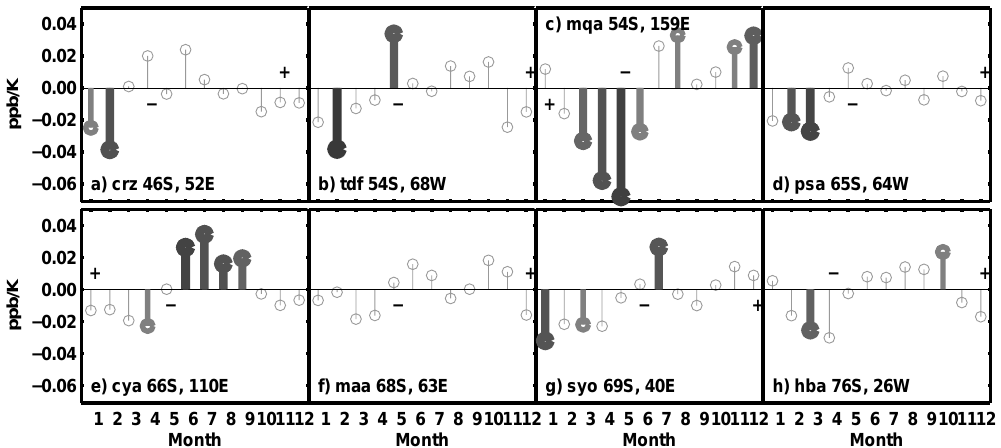
Fig. 11. Stem plots summarizing the linear regression slopes for detrended N 2 O monthly means at 8 different Southern Hemisphere sites spanning 3 monitoring networks vs. mean southern polar spring lower stratospheric temperature. Heavy lines indicate statistically significant correlations at the 5% confidence level, with darker lines, signifying higher R values. Medium grey lines with open circles indicate marginally significant correlations at 10% confidence level: (a) Crozet Island (NOAA/CCGG), (b) Tierra del Fuego (NOAA/CCGG), (c) Macquarie Is- land (CSIRO), (d) Palmer Station (NOAA/CCGG), (e) Casey Station (CSIRO), (f) Mawson (CSIRO), (g) Syowa (NOAA/CCGG), (h) Halley Bay, (NOAA/CCGG).